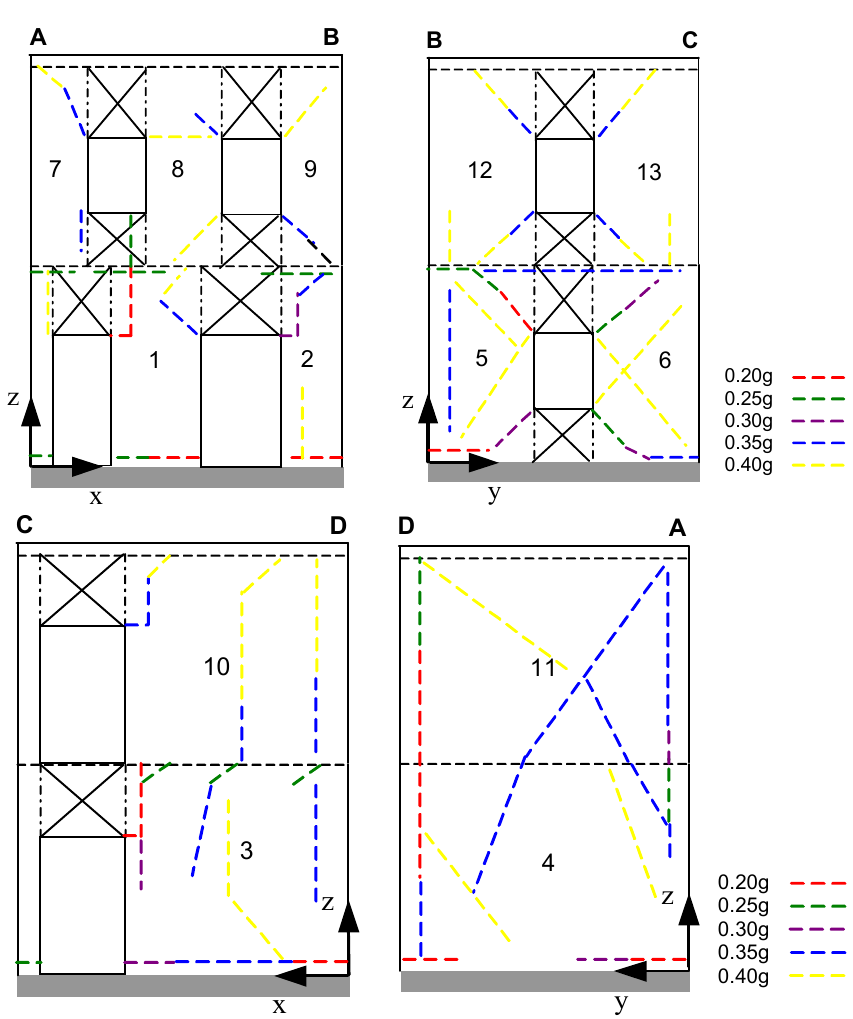
Figure 15. Damage progress obtained by the FE